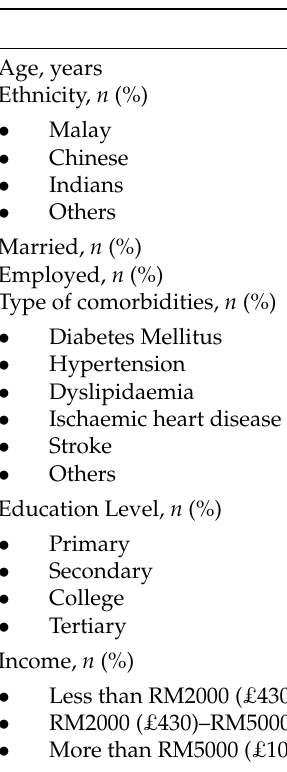
Table 1. Socio-demographic data of patient.